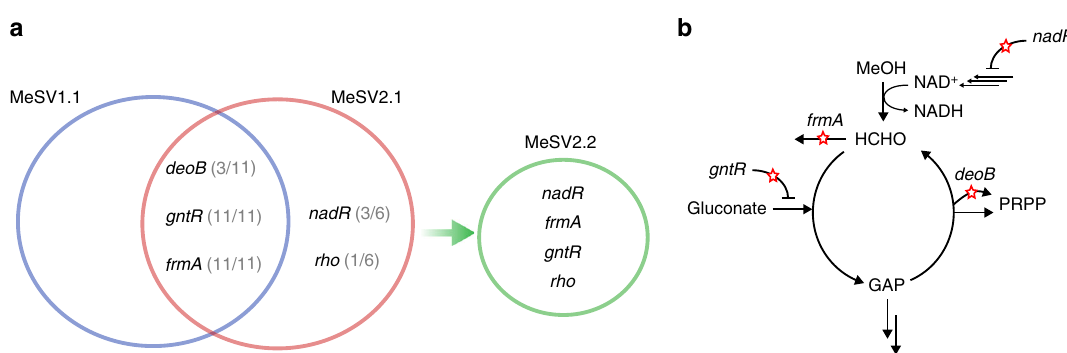
Fig. 6 Prominent mutated genes in evolution experiments. a The fraction of mutations observed in independent evolution experiments is shown in brackets. Number of sequenced populations: MeSV1.1 n = 5, MeSV2.1 n = 6, MeSV2.2 n = 1. Mutations in frmA and gntR appear in all experiments whereas mutations in nadR and rho are only seen in MeSV2 strains. b Prominent mutated genes encoding enzymes in close proximity to branch points of the synthetic RuMP cycle are shown. For a detailed description of all mutations, see Supplementary